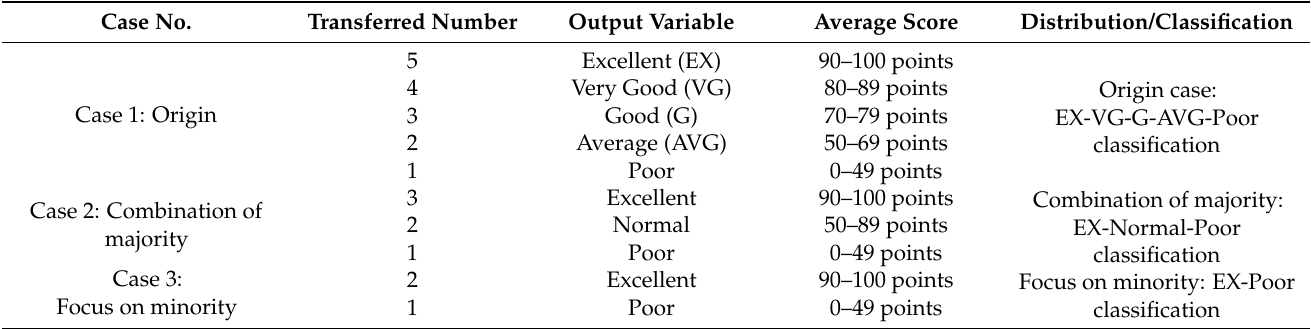
Table 1. The output data transformation.